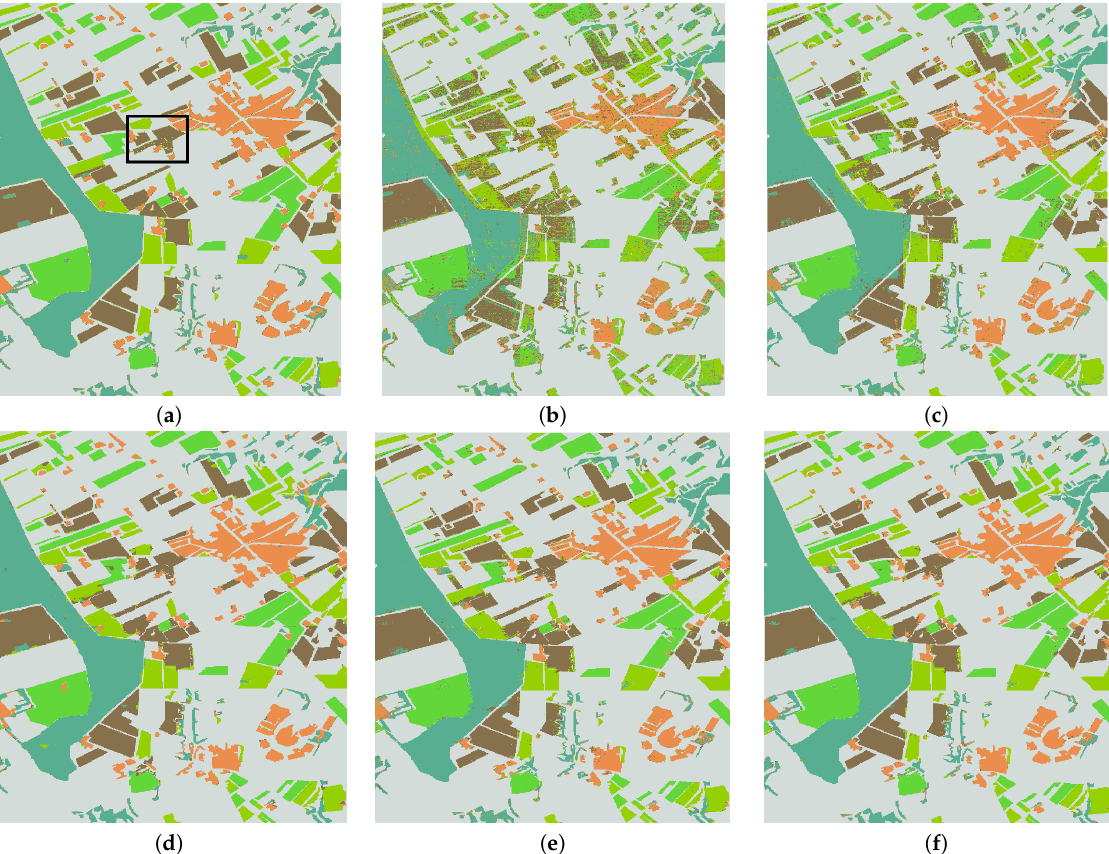
Figure 11. Visual classification of different algorithms on Foulum dataset. ( a ) GT. ( b ) T3: 61.71%. ( c ) TSNE: 80.05%. ( d ) FCN: 91.06%. ( e ) T3-FCN: 89.49%. ( f ) TSNE-FCN: